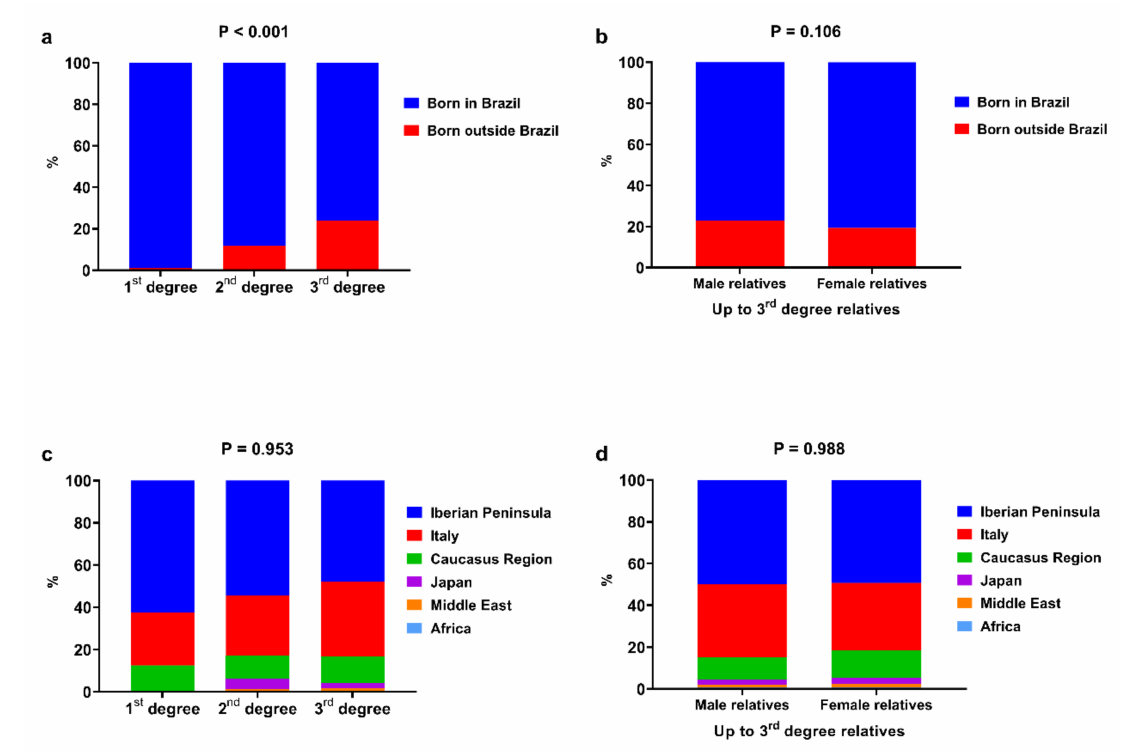
Figure 1. Comparative analysis of family birthplace according to the degree of kindship ( a , c ) and male/female relatives ( b , d ). Chi-square test was performed for statistical